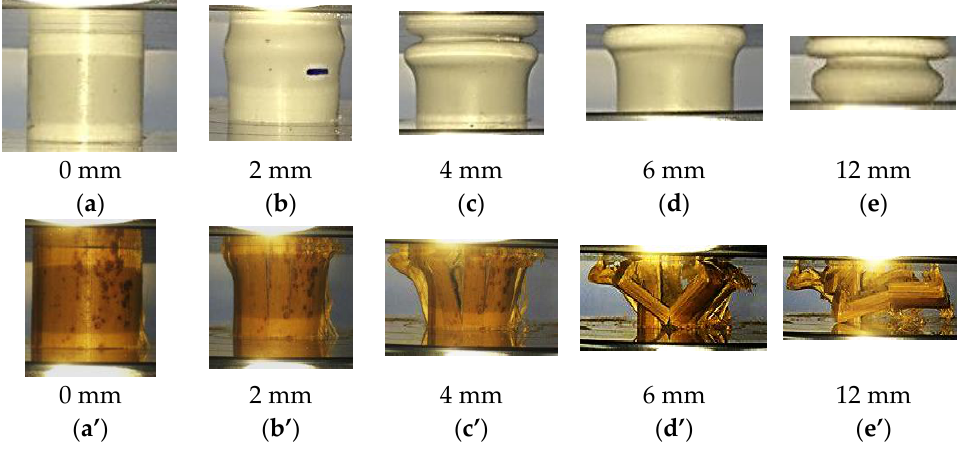
Figure 5. The compression modes at several displacement values of ( a )–( e ) PVC tube and ( a’ )–( e’ ) Bamboo tube.